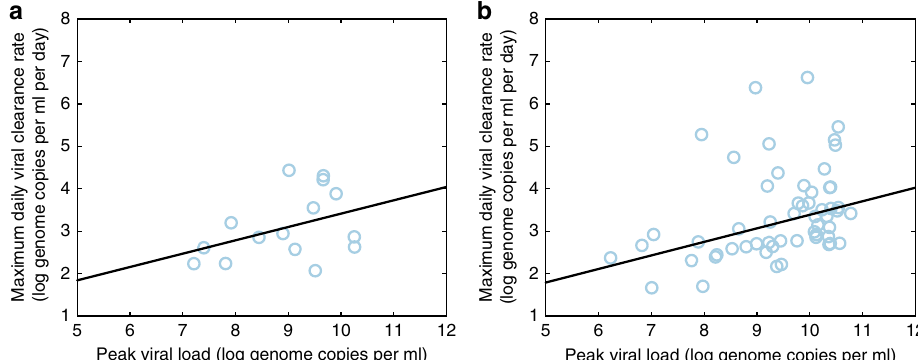
Fig. 1 Empirical relationship between peak viral loads and viral clearance rates in dengue. a Peak viral loads plotted alongside maximum daily viral clearance rates for each of the individuals in the Ho Chi Minh City (HCMC) data set experiencing a primary dengue infection with a detectable viral peak ( n = 15). The relationship is positive with a slope of m = 0.33, trending towards signi fi cance ( p = 0.14, t -test). b Peak viral loads plotted alongside maximum daily viral clearance rates for each of the individuals in the HCMC data set experiencing a secondary dengue infection with a detectable viral peak ( n = 51). The relationship is positive with a slope of m = 0.32 ( p < 0.01, t